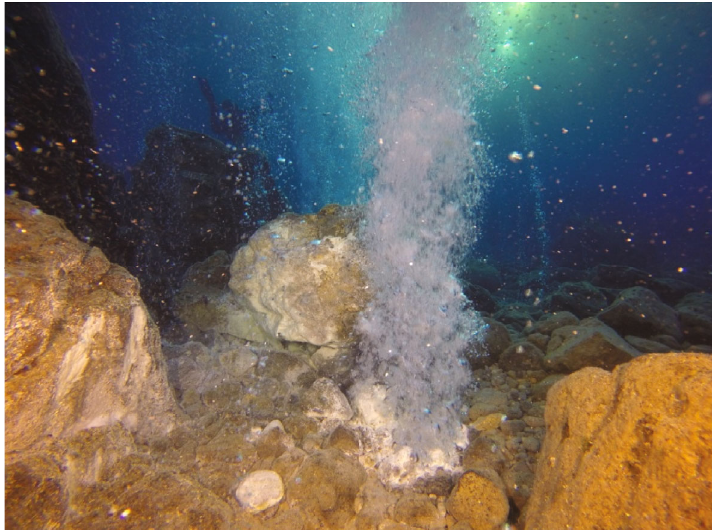
Figure 2: Hydrothermal fl uids emitted from submarine vents at the main hydrothermal fi eld (Bottaro location, 8 m.b.s.l.,